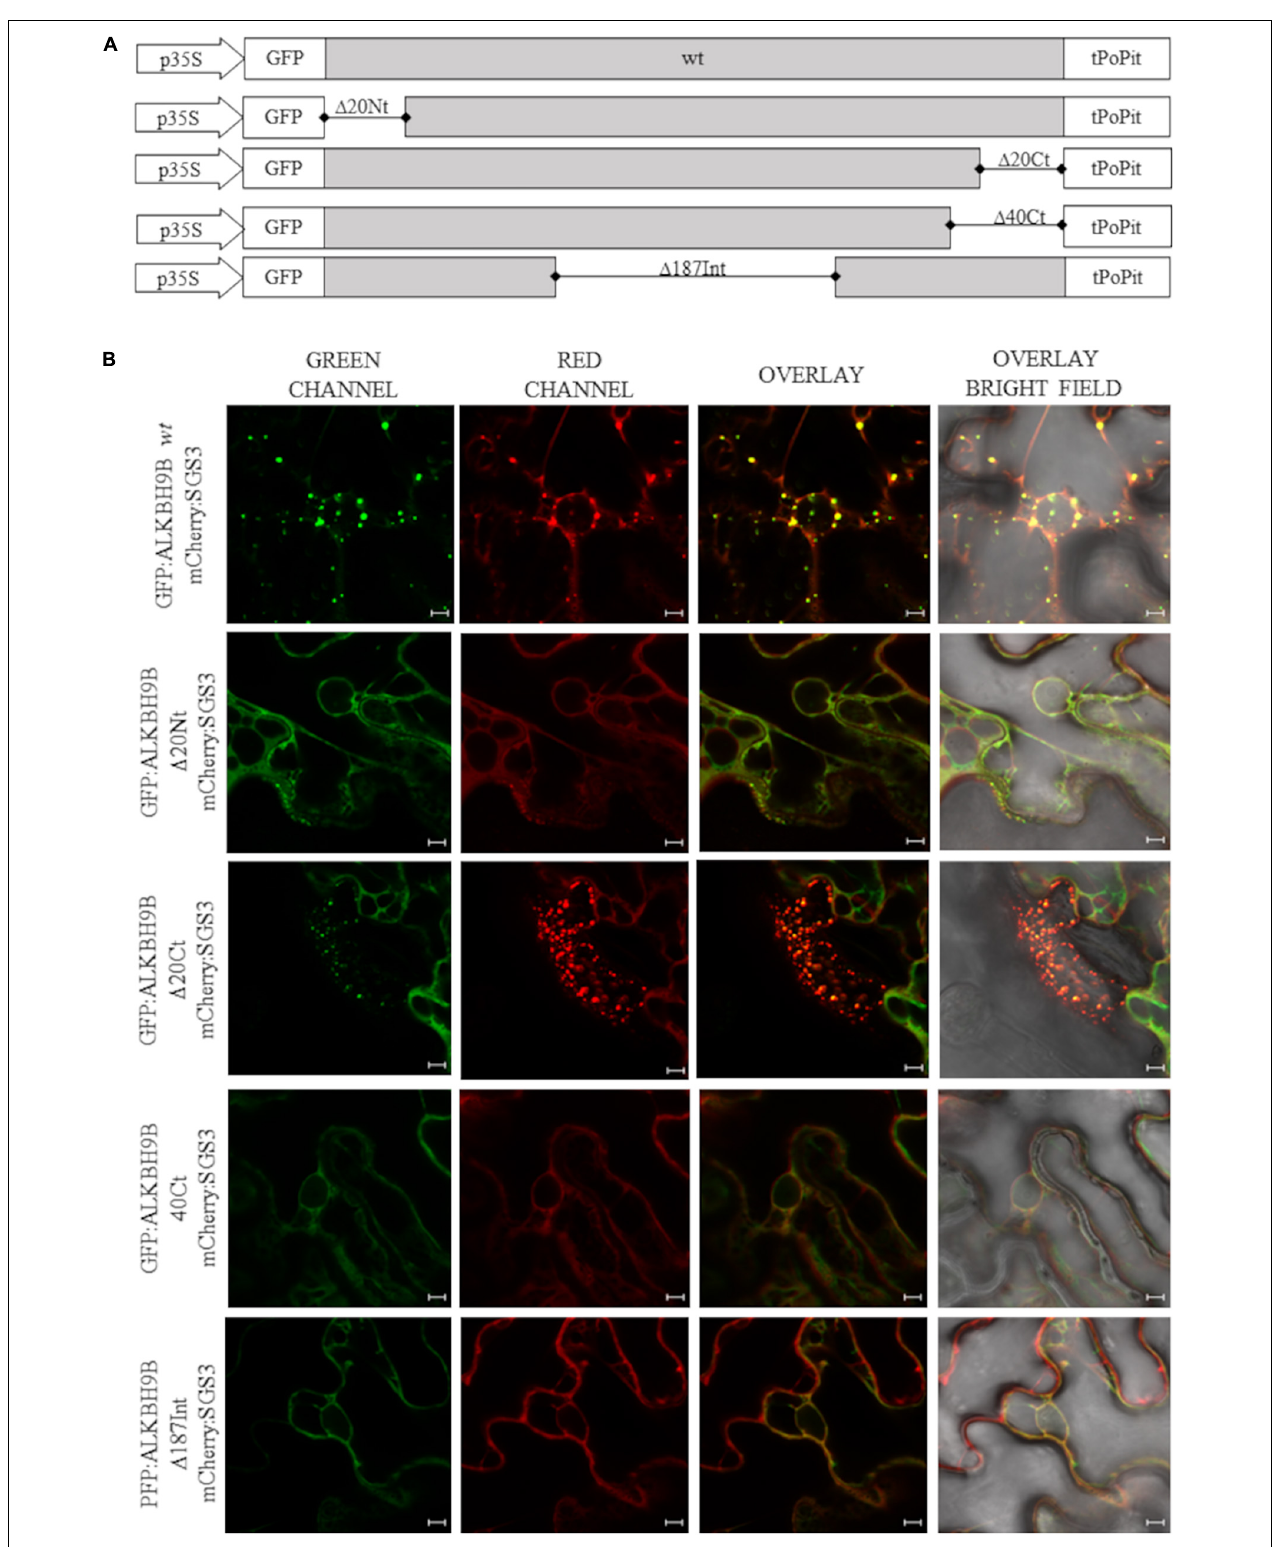
FIGURE 6 | Subcellular localization of at ALKBH9B proteins fused with GFP in infiltrated leaves (A) Schematic representation of the different GFP: at ALKBH9B fusion proteins used. (B) CLSM images of N. benthamiana leaf epidermal cells co-infiltrated with agrobacterium expressing constructs indicated in (A) plus the SGS3 protein fused to the mCherry fluorescent protein (mCherry:SGS3). Scale bar = 20 µ m.